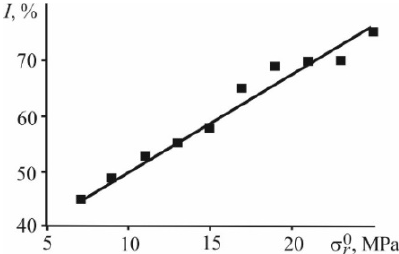
Figure 8. Dependence of FMF on values of residual stresses (markers marked experimental data) The larger the roughness parameter, the smaller the zone of occurrence of final stresses, and the area is more different from the correct circle.